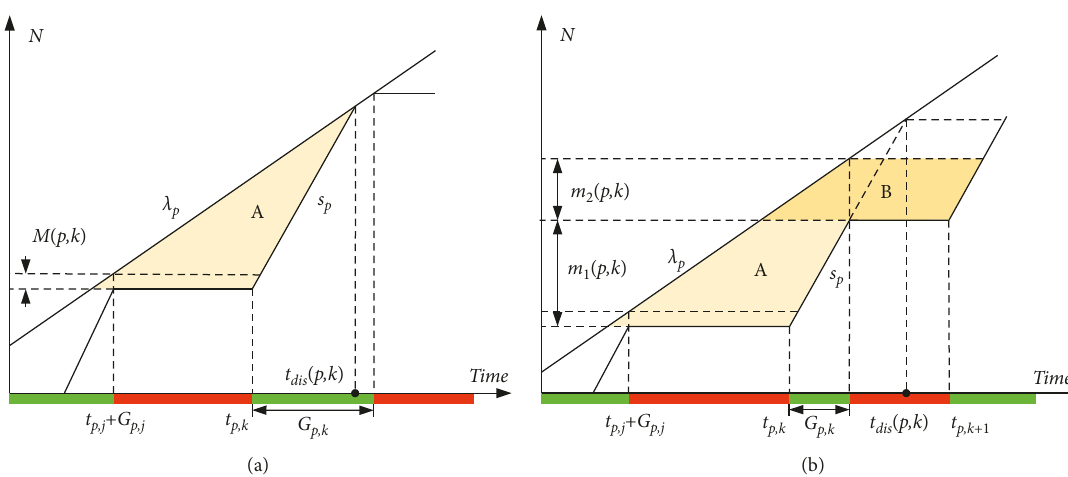
Figure 4: Illustration of queue dissipating and car passenger delay. (a) Queue dissipates without secondary stop (b) Queue dissipates with secondary